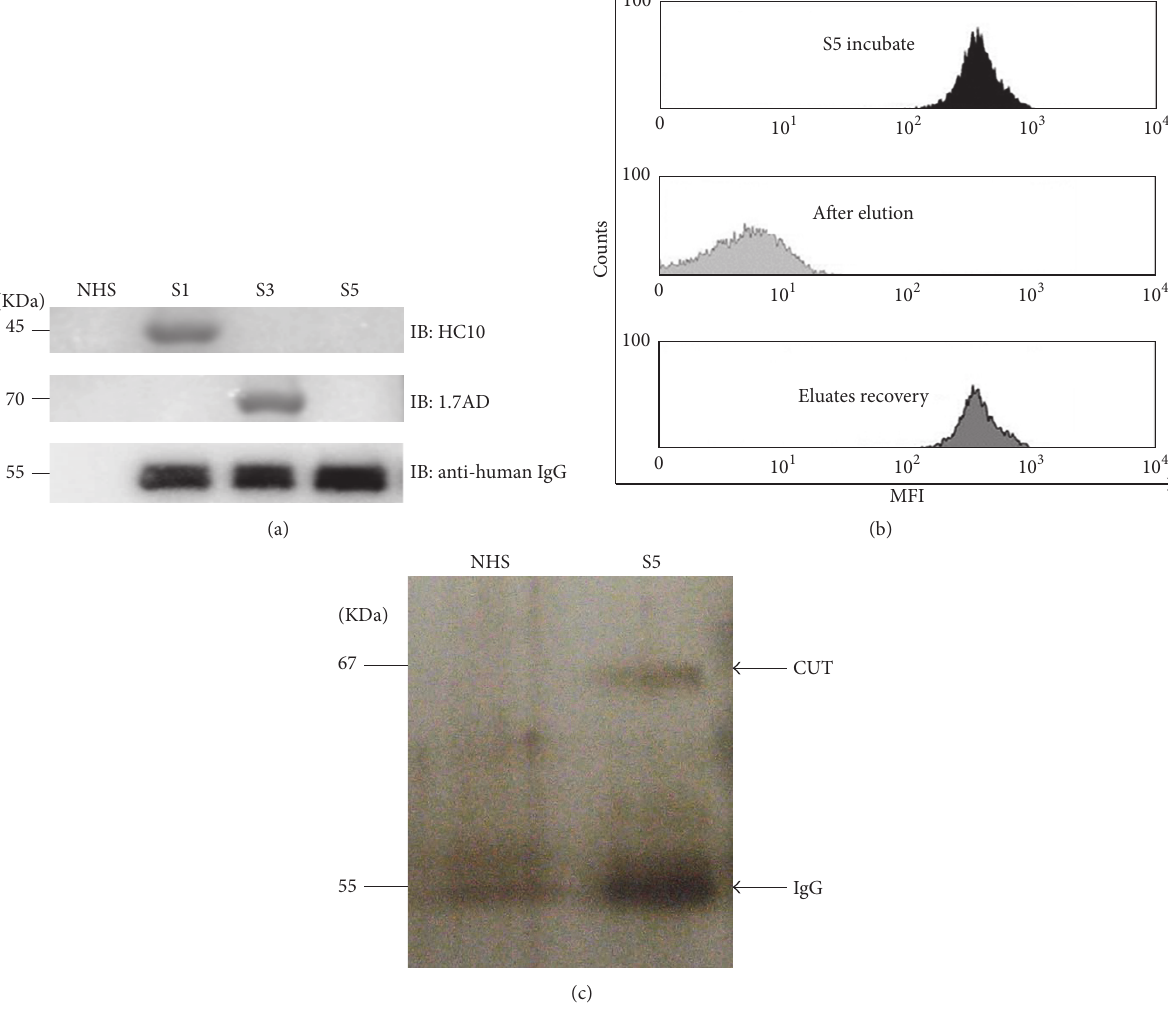
Figure 3: Antibody elution and EC target antigen immunoprecipitation. (a) Sera S1, S3, and S5 with anti-HLA, anti-MICA, and anti-EC antibodies, respectively, as well as normal human serum were incubated with HUVECs. HUVECs were lysed, and the antibody-antigen complex was captured using protein-G magnet beads. Precipitated proteins were separated on SDS-PAGE, and immunoblots (IB) were performed using HC10 (anti-HLA heavy chain), 1.7AD (anti-MICA), and anti-human IgG, respectively. (b) HUVECs were incubated with serum S5 (top), supernatant after elution step (middle), and serum antibodies were enriched by antibody absorption and elution as shown in Figure 2, left. (c) Proteins precipitated with S5 were separated on SDS-PAGE and revealed by silver staining. Normal human serum was used as negative control. The captured antigen from HUVECs and IgG bands are